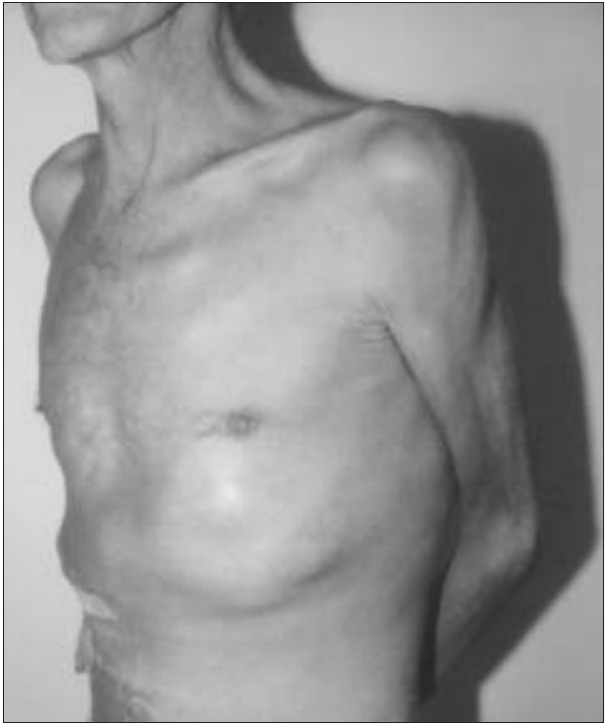
Figure 1) Clinical photograph of the patient at the time of presentation demonstrating a large mass in the left uppper abdominal quadrant and chest